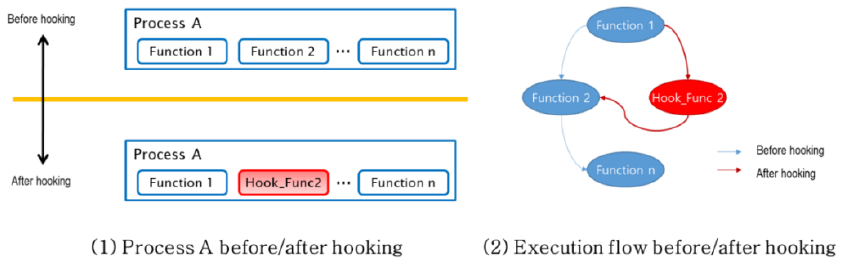
Figure 5. Conceptual diagram of hooking.